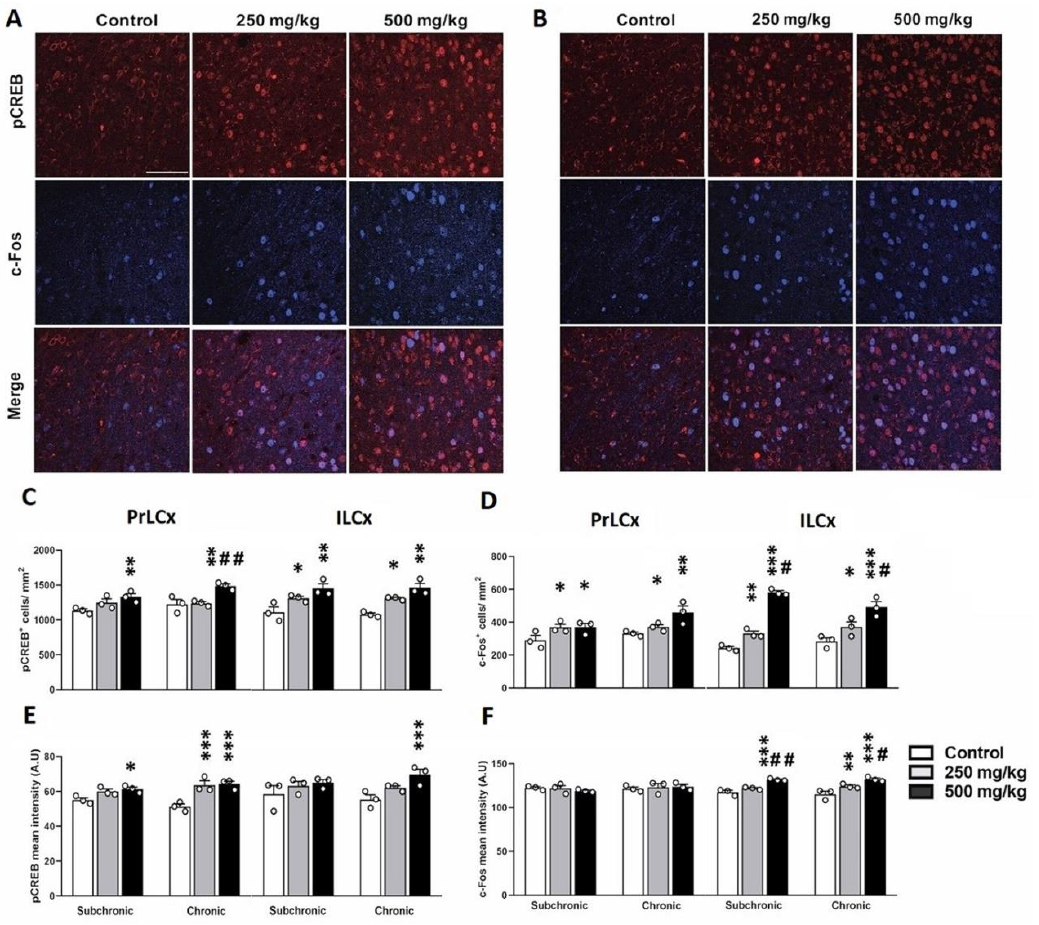
Figure 2. Effects of GBH on pCREB and c-Fos expression in the mPFC. Representative confocal images illustrating pCREB + and c-Fos + distribution in the PrLCx ( A ) and the ILCx ( B ) of animals injected either with GBH or vehicle for a chronic period. Histograms showing the analyses of pCREB + ( C ) and c-Fos + ( D ) cell density. Optical density analysis of pCREB ( E ) and c-Fos ( F ) immunofluorescence. * p < 0.01; ** p < 0.01; *** p < 0.001; # p < 0.05; ## p < 0.01. * indicates comparison between control vs. 250 mg/kg and 500 mg/kg groups; # indicates comparisons between 250 mg/kg vs. 500 mg/kg group. Scale bar: 10 µ